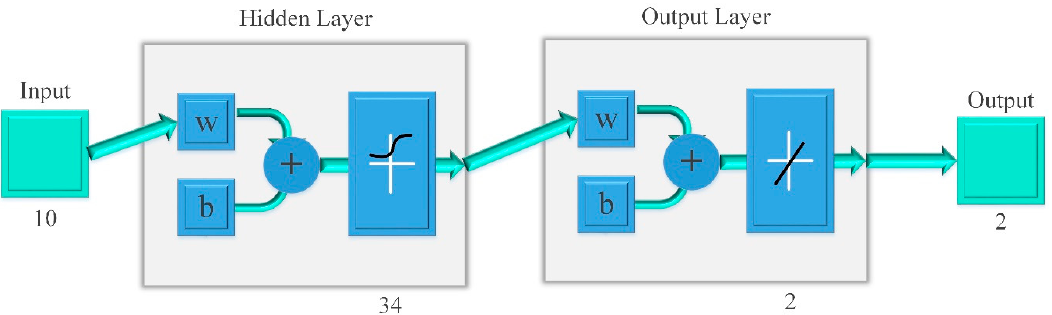
Figure 8. The schematic of DBN structure.